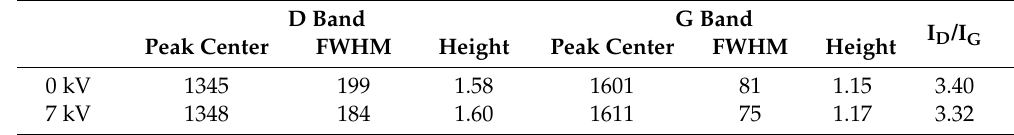
Table 7. Results of the peak fitting with Lorentzian function.